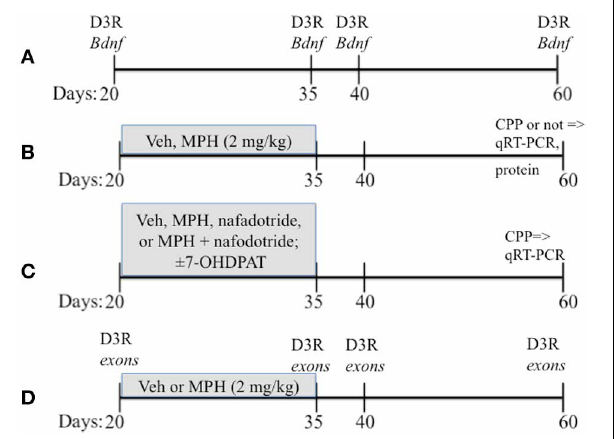
FIGURE 1 | A schematic showing the overall experimental design that includes the timing of drug treatments. Vehicle (Veh), methylphenidate (MPH), conditioned place preferences (CPP). Ages of rats are in days. (A–D) presents a schematic of the paradigms used for Experiments